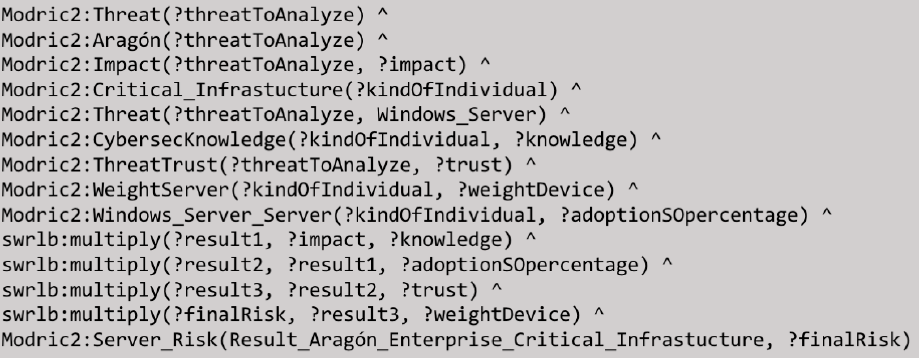
Figure 6. Example of a Semantic Web Rule Language (SWRL) rule for risk calculation.